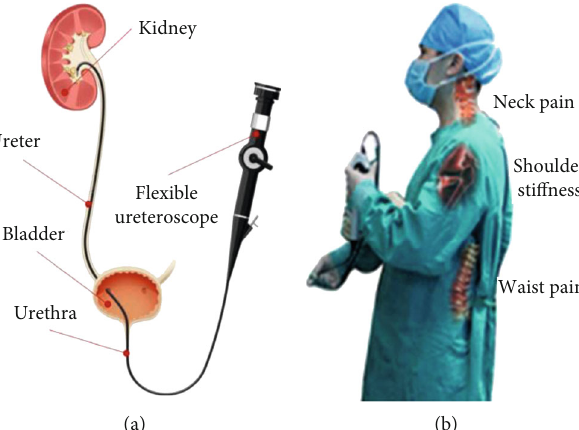
Figure 1: (a) The operational path of FURS in anatomy; (b) the typical physical fatigue and injury caused by the manual FURS